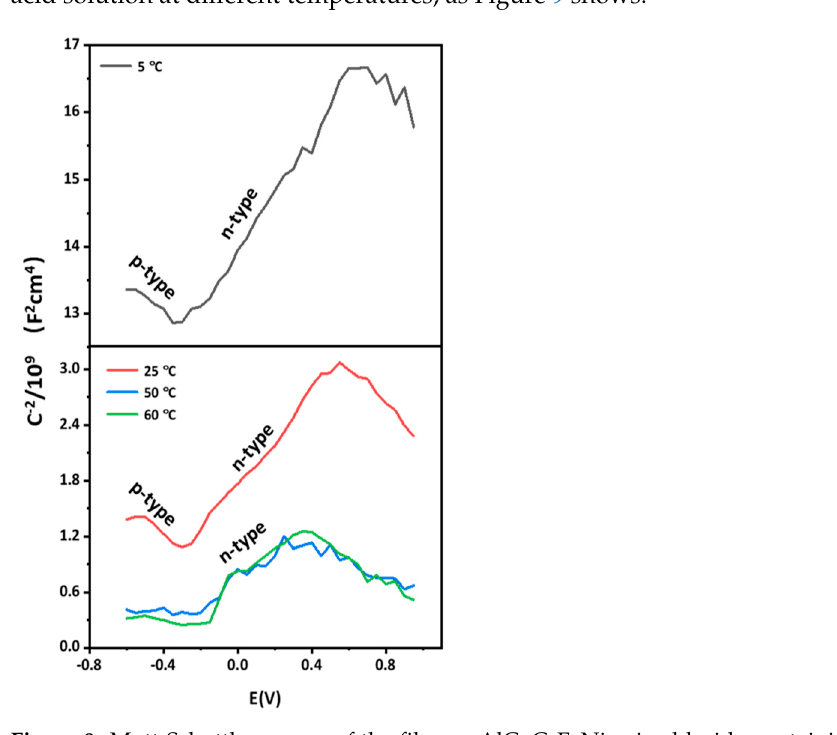
Figure 8. Mott-Schottky curves of the film on AlCoCrFeNi 2.1 in chloride-containing sulfuric acid solution at different temperatures.